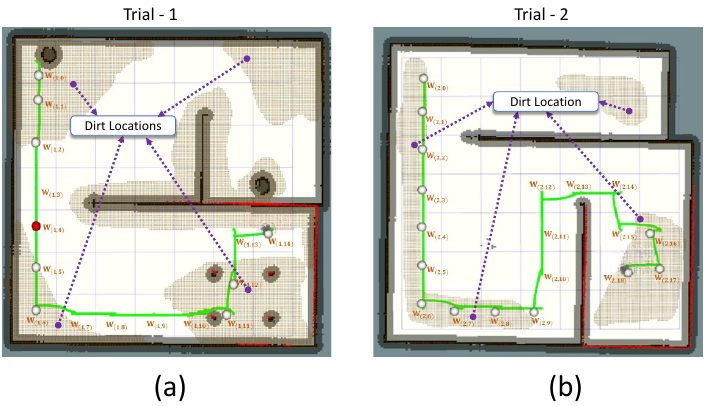
Figure 9. The explored locations by the robot in simulated environments of Trial-1 ( a ) and Trial-2 ( b ) and the path